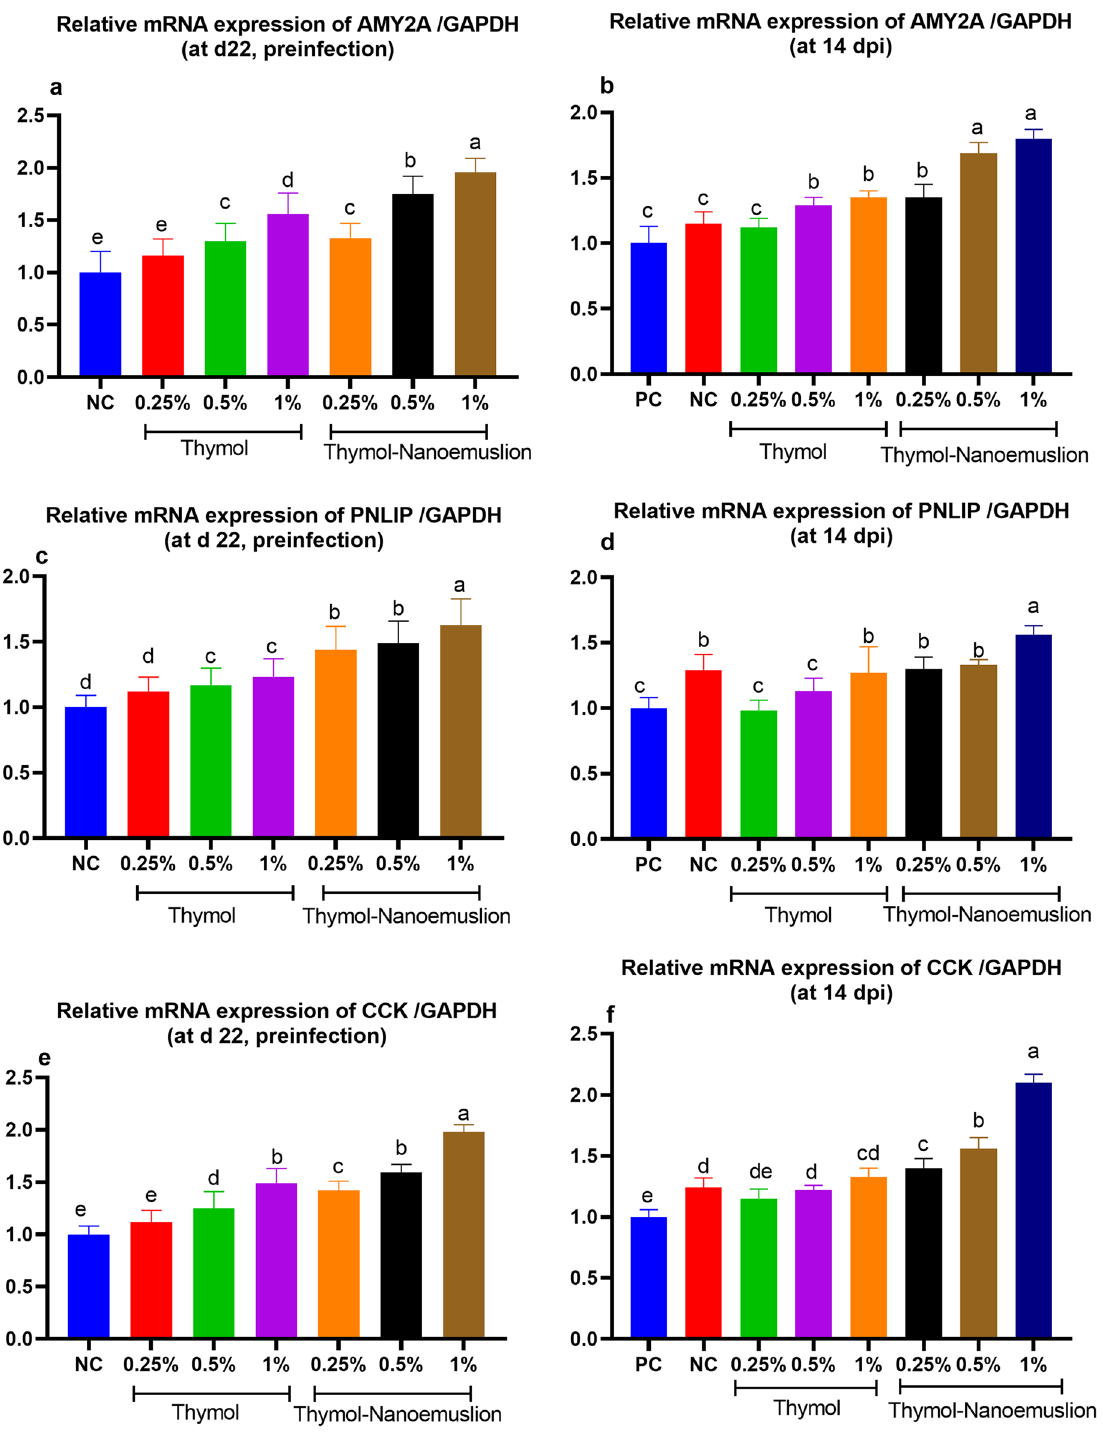
Figure 1. Levels of AMY2A ( a , b ), PNLIP ( c , d ) and CCK ( e , f ) mRNA expression in the pancreas of broiler chickens fed different levels of thymol and thymol nanoemulsion preinfection (d 22) and 14 days postinfection (14 dpi) with S . Typhimurium as were measured by RT-qPCR assay. Values are means with their SE in bars. At d 22 preinfection: NC (negative control) = birds fed basal diet, thymol 0.25, 0.5 and 1% = birds fed basal diet supplemented with 0.25, 0.5 and 1% thymol, thymol nanoemulsion 0.25, 0.5 and 1% = birds fed basal diet supplemented with 0.25, 0.5 and 1% thymol nanoemulsion. At 14 dpi: NC (negative control): birds fed basal diet; PC (positive control): birds fed basal diet and challenged with S . Typhimurium at d 23 of age; thymol 0.25, 0.5 and 1%: birds fed basal diet supplemented with 0.25, 0.5 and 1% thymol; thymol nanoemulsion 0.25, 0.5 and 1%: birds fed basal diet supplemented with 0.25, 0.5 and 1% thymol nanoemulsion. All groups except NC group were challenged with S . Typhimurium at d 23 of age. a–e Means within the same column carrying different superscripts are significantly different at p <